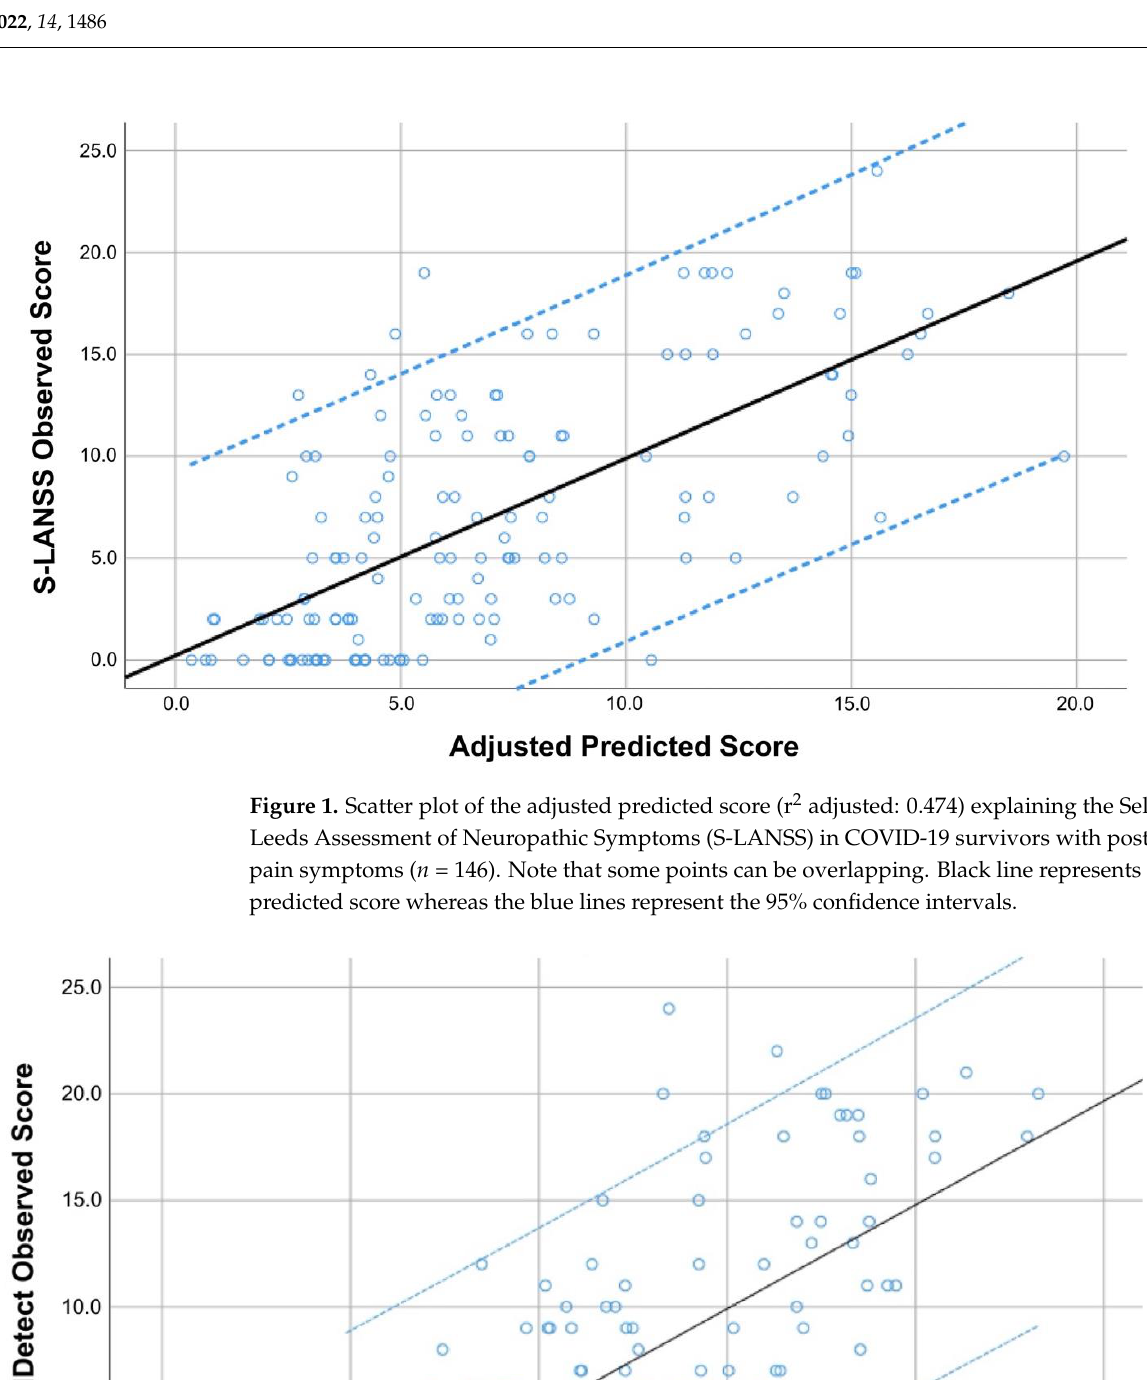
Table 4. Summary of the stepwise regression analyses to determine predictors of PainDETECT.